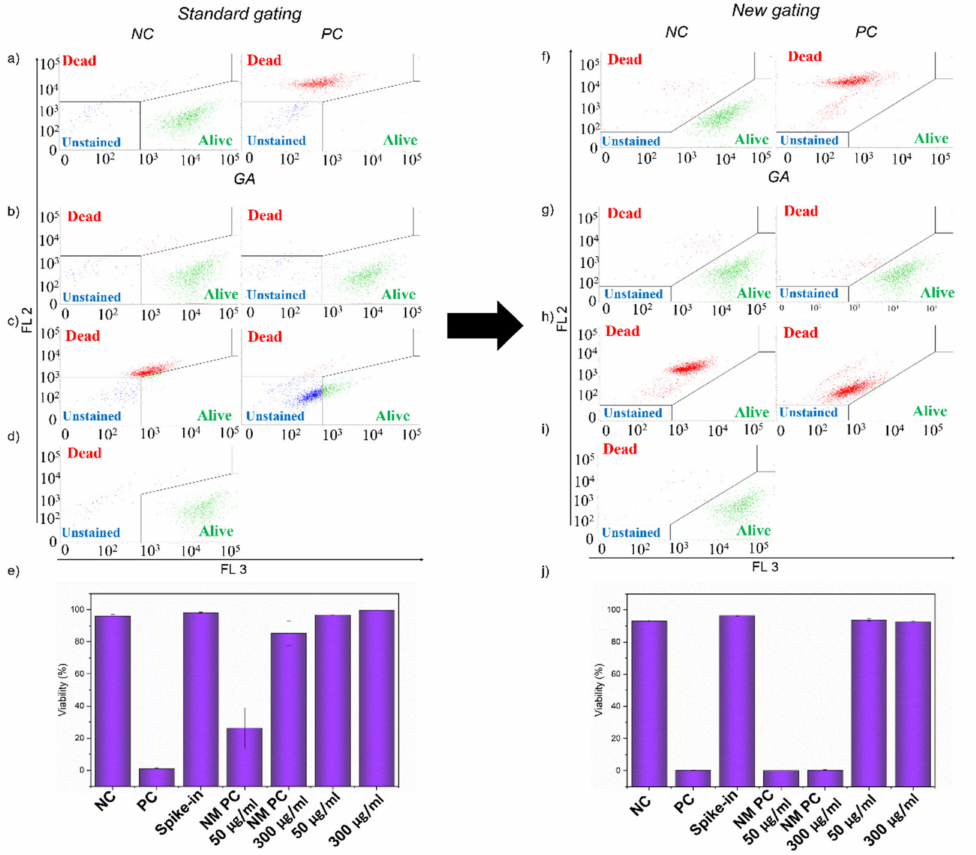
Figure 6. Dot plot showing LIVE/DEAD assay of: ( a , f ) negative and positive control of BJ cells and ( b – d , g – i ) BJ cells treated with GA samples with ( a – d ) standard gating and ( f – i ) new gating approach. ( b , g ) Samples treated with 50 µ g/mL ( left ) and 300 µ g/mL ( right ) of GA for 24 h; ( c , h ) Samples treated with NM PC 50 µ g/mL ( left ) and NM PC 300 µ g/mL ( right ); ( d , i ) Spike-in control for GA. ( e , j ). The evaluation of the viability of BJ cells treated with GA and additional control samples ( n = 3). The events in the alive gate are shown in green, events in the dead gate in red and events in the unstained gate are highlighted in